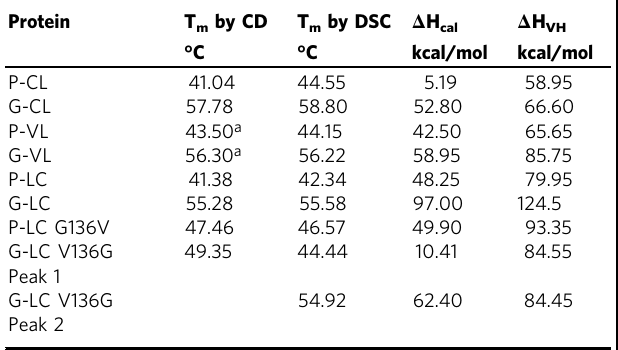
(CSM) for P-CL which indicates higher solvent exposure of the (25 vs. 37 °C) is more pronounced in P-CL than in G-CL (Fig. 3a).